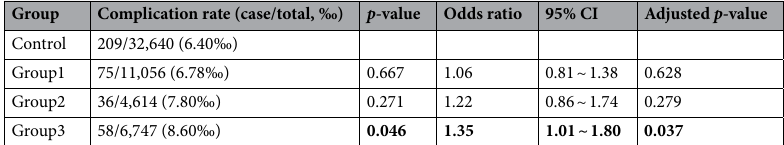
Tabel 4. Rate of venous complications in pregnancy and puerperium in different AR conditions. Significant values are in bold. Group 1: with AR before; without AR after childbirth. Group 2: without AR before; with AR after childbirth. Group 3: with AR before; with AR after childbirth. Adjusted p -value: adjust for AS, medical comorbidities, pregnancy characteristics, delivery complications, urbanization, jobs, age and birth type.